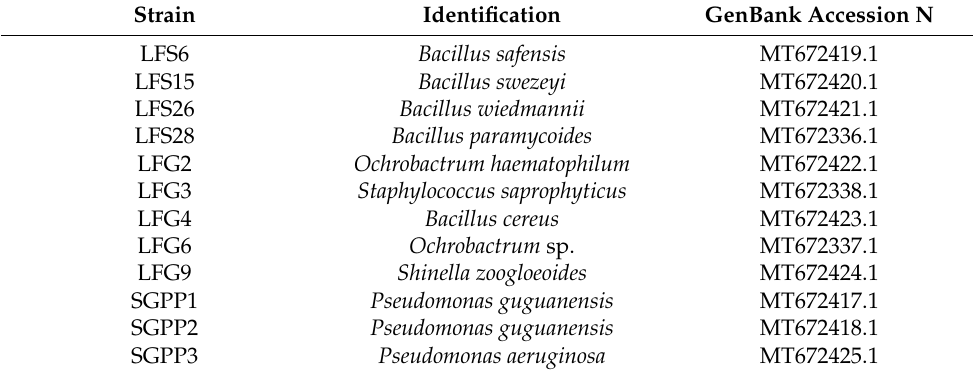
Table 3. Bacterial strain identification.